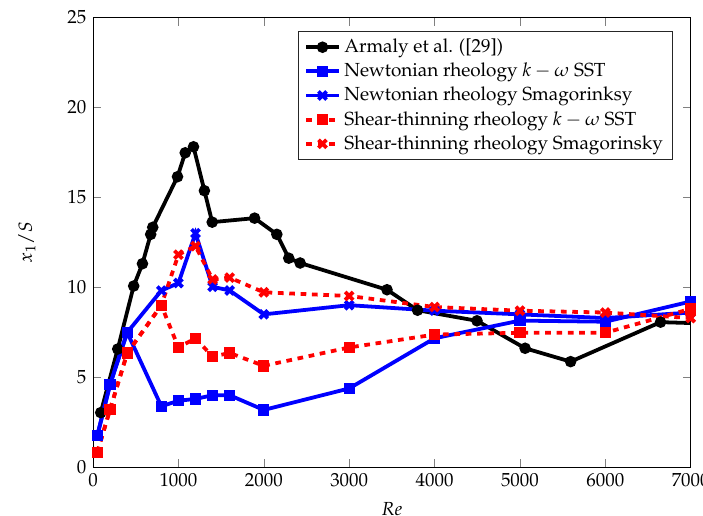
Figure 8. Time-averaged and spatially averaged primary recirculation x 1 normalised by step height S for Newtonian and shear-thinning blood rheology for both k ω SST and Smagorinsky is plotted as a function of Reynolds number. Experimental data (black line) from Armaly et al. [29] is also shown.